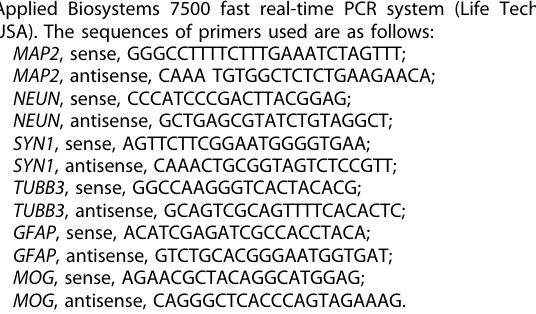
Fig. 6 HDAC inhibitors cooperate with 8-CPT-cAMP to induce neuronal differentiation of human glioma stem cells (GSCs). A Morphology alteration of human GSCs (GSC-1 and GSC-11 cells) treated with V, C, M, CM for 48 h. Pictures were taken at ×20 magni fi cation. Scale bars, 50 μ m. B Quanti fi cation of EdU-positive cells in GSC-1 and GSC-11 treated with V, C, M, CM for 48 h. C Flow cytometry analysis for testing the protein levels of MAP2/TUBB3 in GSC-1 and GSC-11 cells treated with V, C, M, CM for 48 h. D Western blot analysis for testing H3K9/K14ac and CD133 expression in GSC-1 (left) and GSC-11 cells (right) treated with V, C, M, CM for 48 h. E Immuno fl uorescent analysis for voltage-gated sodium channels (NaV) in GSC-1 and GSC-11 treated with CM for 72 h. Pictures were taken at ×40 magni fi cation. Scale bars, 25 μ m. F , G GO analysis after RNA-seq and heatmaps of dysregulated genes for GSC-11cells treated with V and CM for 48 h. Blue: upregulated genes (CM vs V), red: downregulated genes (CM vs V). Red lines indicate adjusted P = 0.05. H Gene enrichment analysis of genes with altered H3K9ac/H3K14ac tags after ChIP-seq in GSC-11 cells treated with V and CM for 48 h. Red trace lines indicate adjusted P = 0.05. All data was compared to vehicle with one-way ANOVA. n.s., not signi fi cant; * P < 0.05; ** P < 0.01; **** P < 0.0001. Mean ± SD is shown in the bar plot ( n = 3 per group). V, Vehicle (1 ‰ DMSO); C, 0.5 mM 8-CPT-cAMP; M, 1 μ M